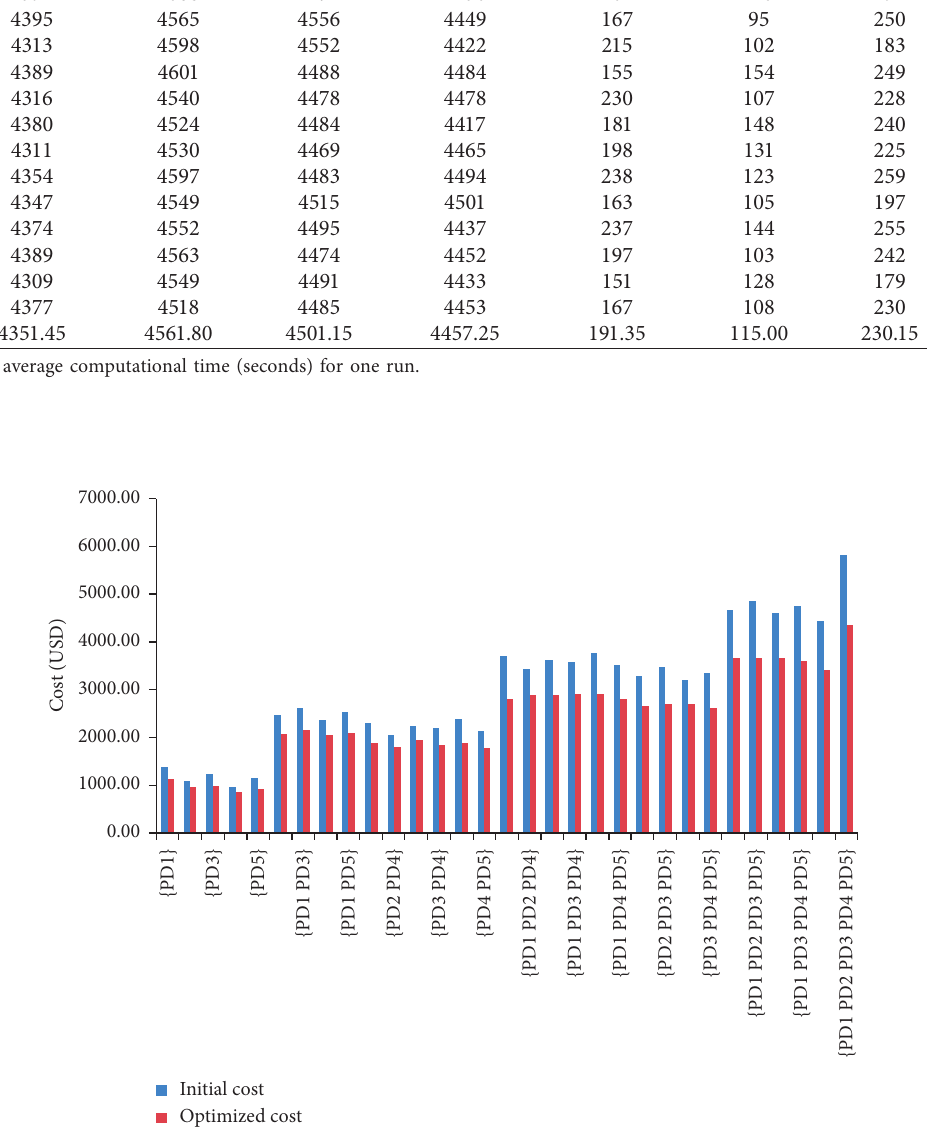
Figure 5: Comparison between initial and optimized networks’ cost solutions.